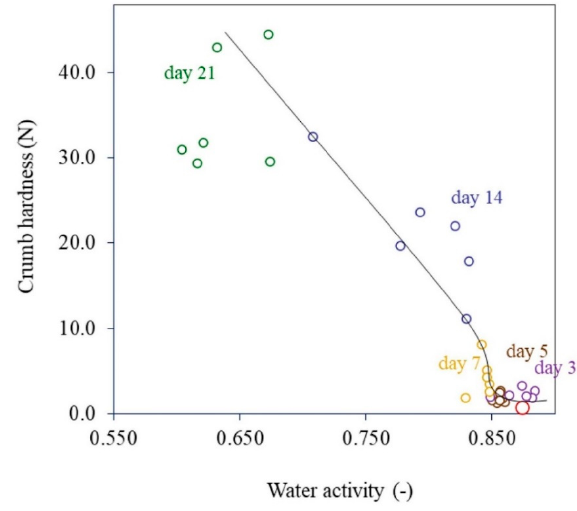
Figure 1. The relationship between water activity and crumb hardness during storage for 21 days in biodegradable films at room temperature (Reproduced with permission from Srisa and Harnkarnsujarit (2020) [24]).